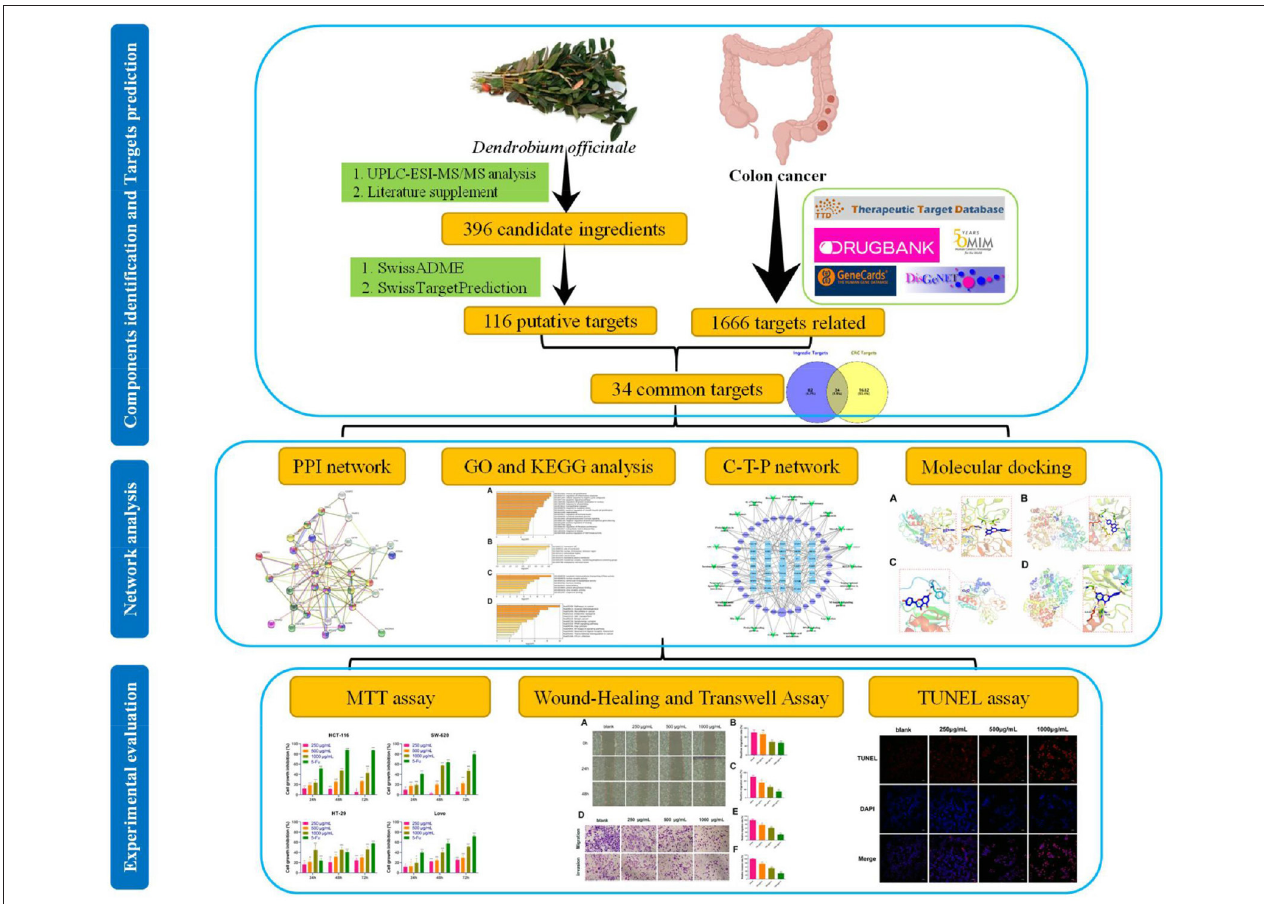
FIGURE 1 | Workflow of network pharmacology analysis and validation of D. officinale on